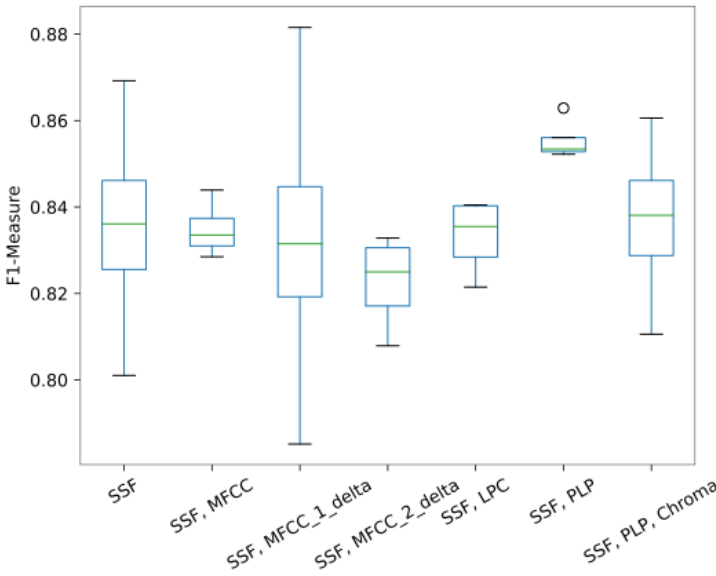
Figure 7. Performance of the best possible feature combinations in the Electrobyte dataset. Circles represent atypical values within the evaluation metrics.